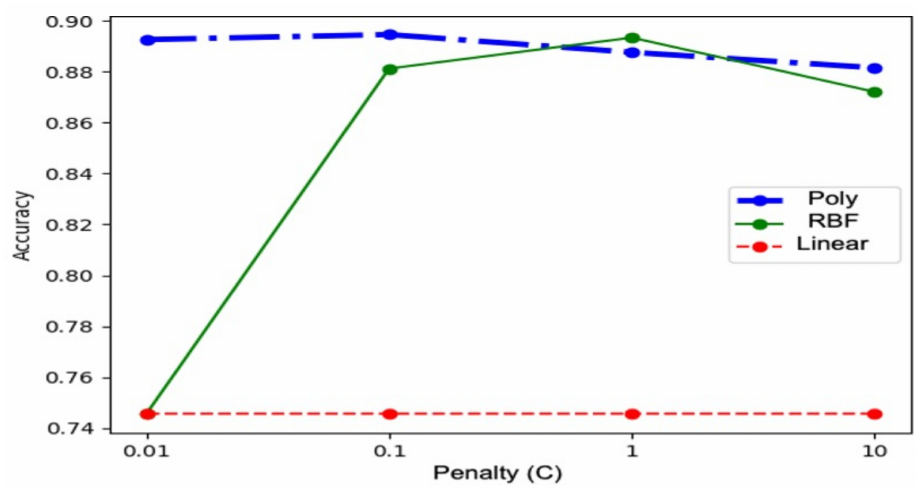
Figure A1. Accuracy of different SVM classifier kernels over the values of penalty C values.